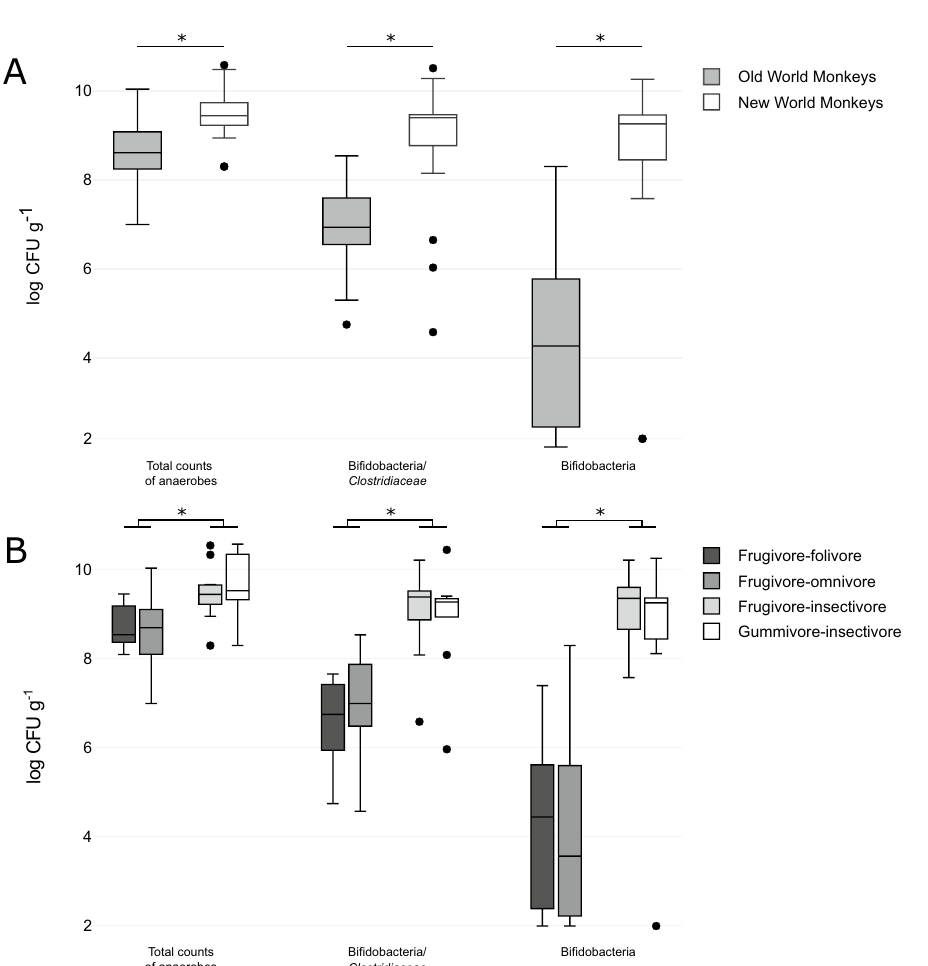
Figure 1. Quantification of cultivable anaerobic bacteria (log CFU g -1 ) in primate faecal samples. ( A ) Cultivation counts of bacteria per parvorder: New World monkeys (n = 24) and Old World monkeys (n = 28). ( B ) Cultivation counts of bacteria per feed category: frugivore-folivore (n = 8), frugivore-omnivore (n = 21), frugivore-insectivore (n = 13), gummivore-insectivore (n = 10). Asterisks (*) denote statistically significant differences as determined by t-test and ANOVA (p <